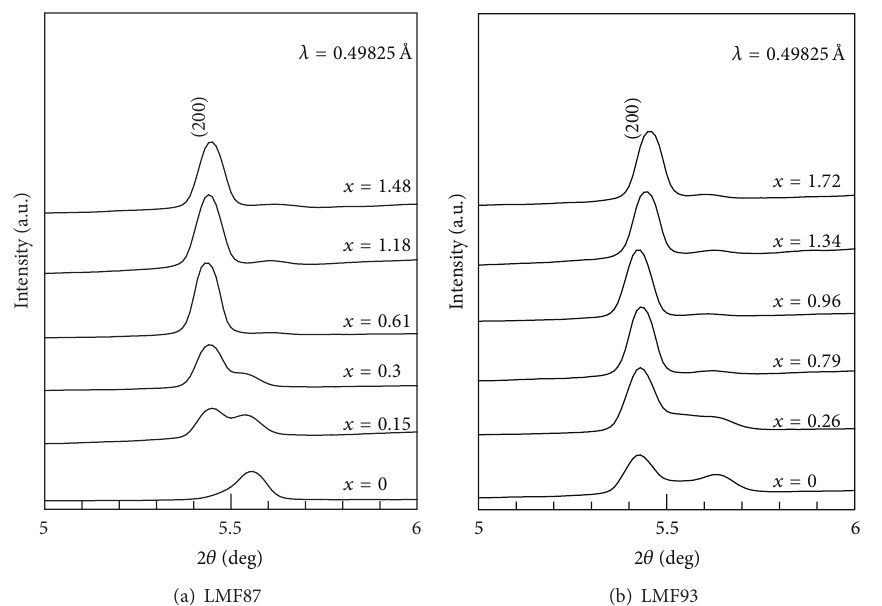
Figure 7: Magnified XRD patterns of (a) LMF87 and (b) LMF93 against 𝑥 . Values in the parentheses represent indexes in the face-centered- cubic setting (cited from